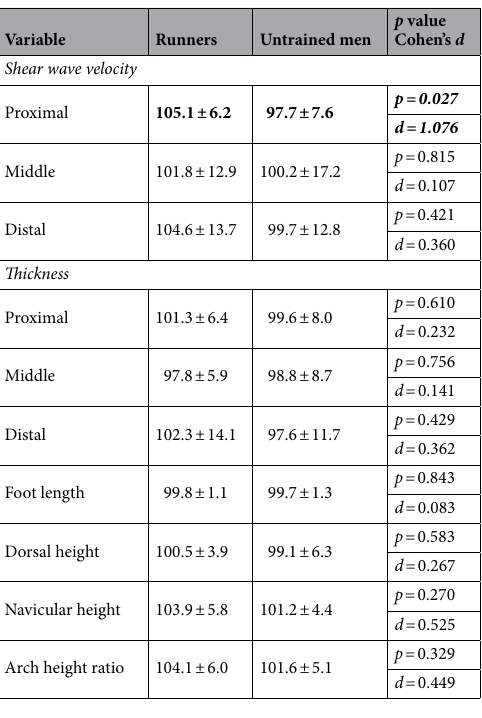
Table 2. Left/right ratios (%) of individual parameters in runners and untrained men. Data are shown as means ± SD. Bold fonts indicate significant difference between runners and untrained men ( p < 0.05) with a “large” effect size ( d ≥ 0.8).